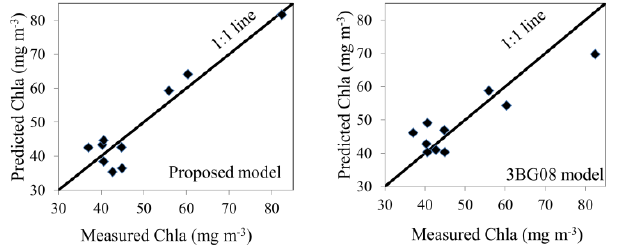
Figure 3. The comparison between measured and predicted Chla in proposed model (left) and reference model – 3BG08 (right)